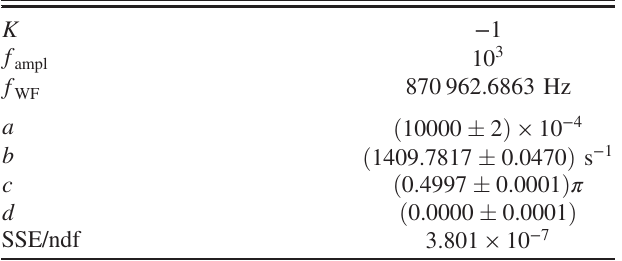
FIG. 5. Simulated driven oscillations on resonance using from Eq. (42) with initial vertical polarization ¼ 90 ° [Eq. (41)] for the parameters given in [Eq. (37)], and ϕ WF rot Table I and for the harmonic K ¼ − 1 . The plot contains 101 points for a total of 10 000 turns.